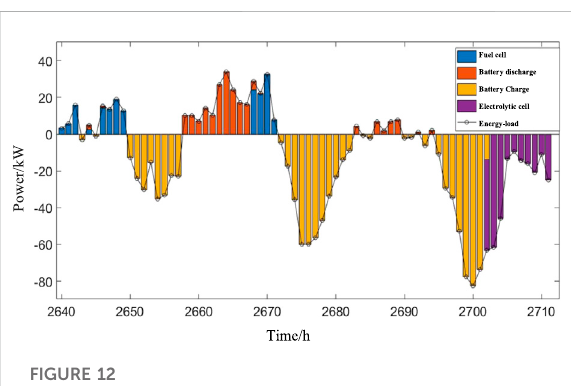
FIGURE 12 Powerbalancediagramofthesystemforacertainthreedays.